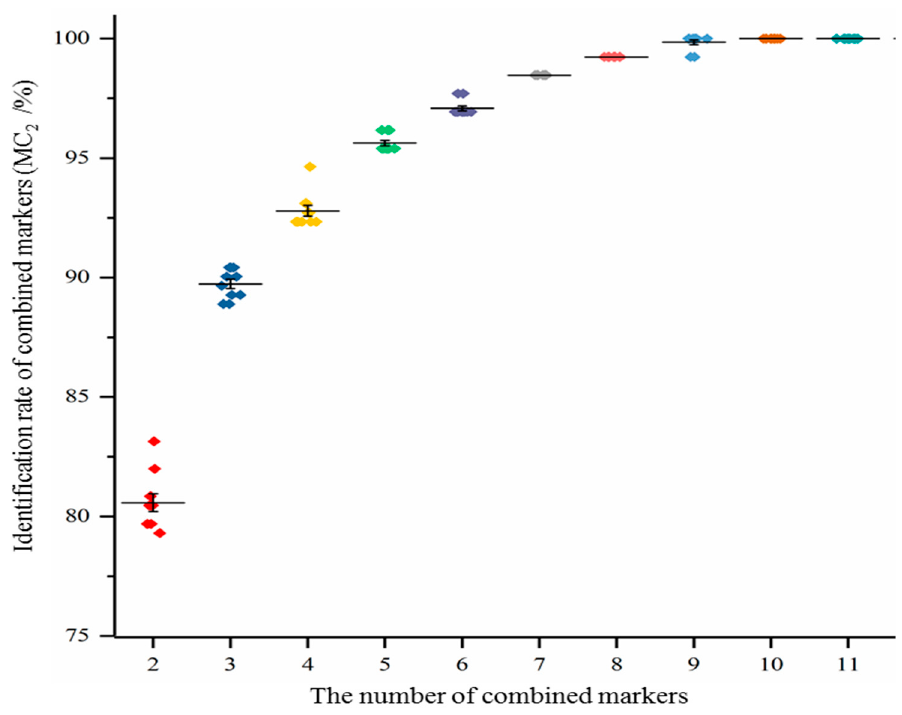
Figure 1. MC 2 of different number of combined markers.